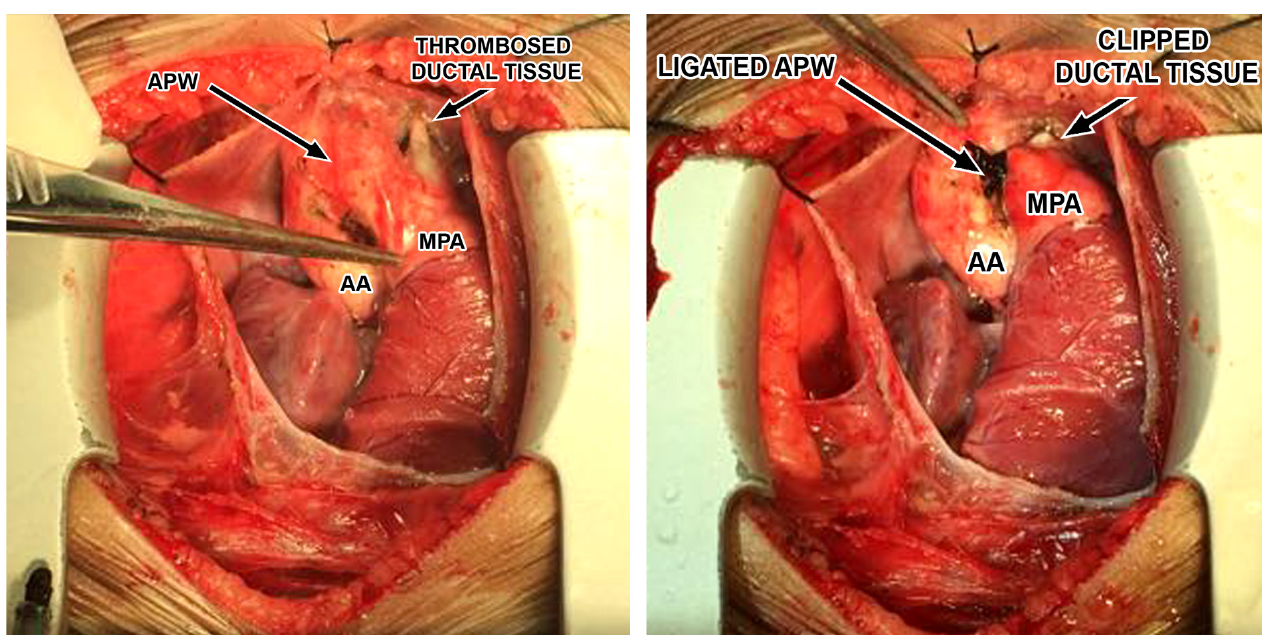
Fig. 3 – Intraoperative image showing aortopulmonary window and pulmonary artery with thrombosed intervening ductal